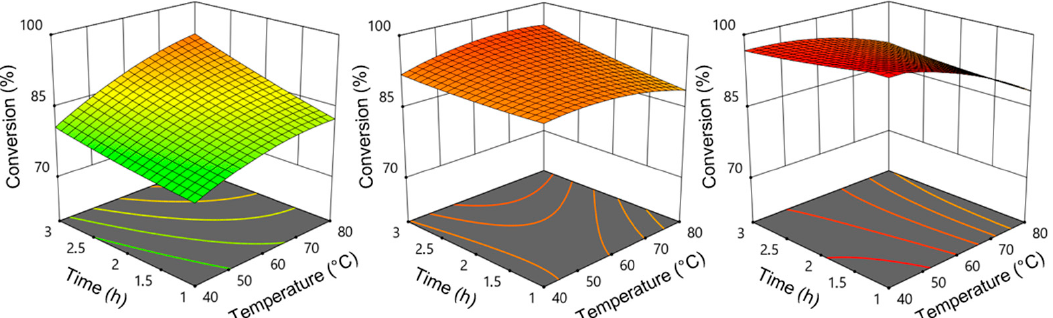
Figure 4. The 3D plots obtained when the molar ratio of the reactants was medium (7:1) and the value of the mass fraction of the catalyst was the lowest (1%, ( left )), medium (2%, in the ( middle )) and the highest (3%, ( right )).